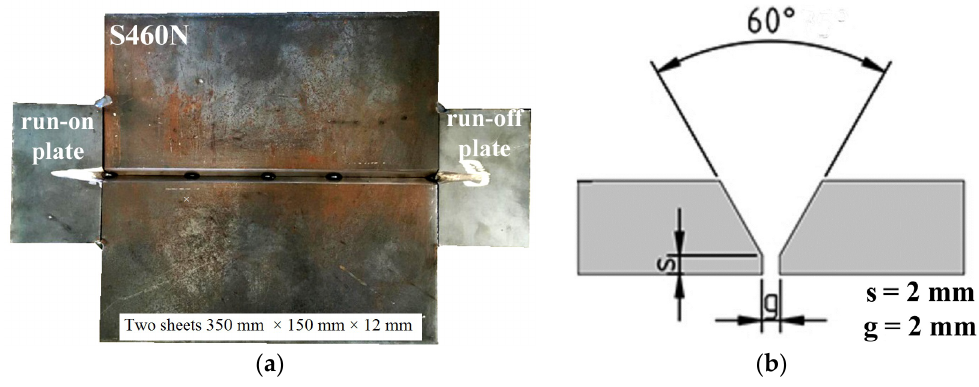
Figure 2. ( a ) The real view of the specimen before welding and ( b ) schematic cross-section of the specimen.